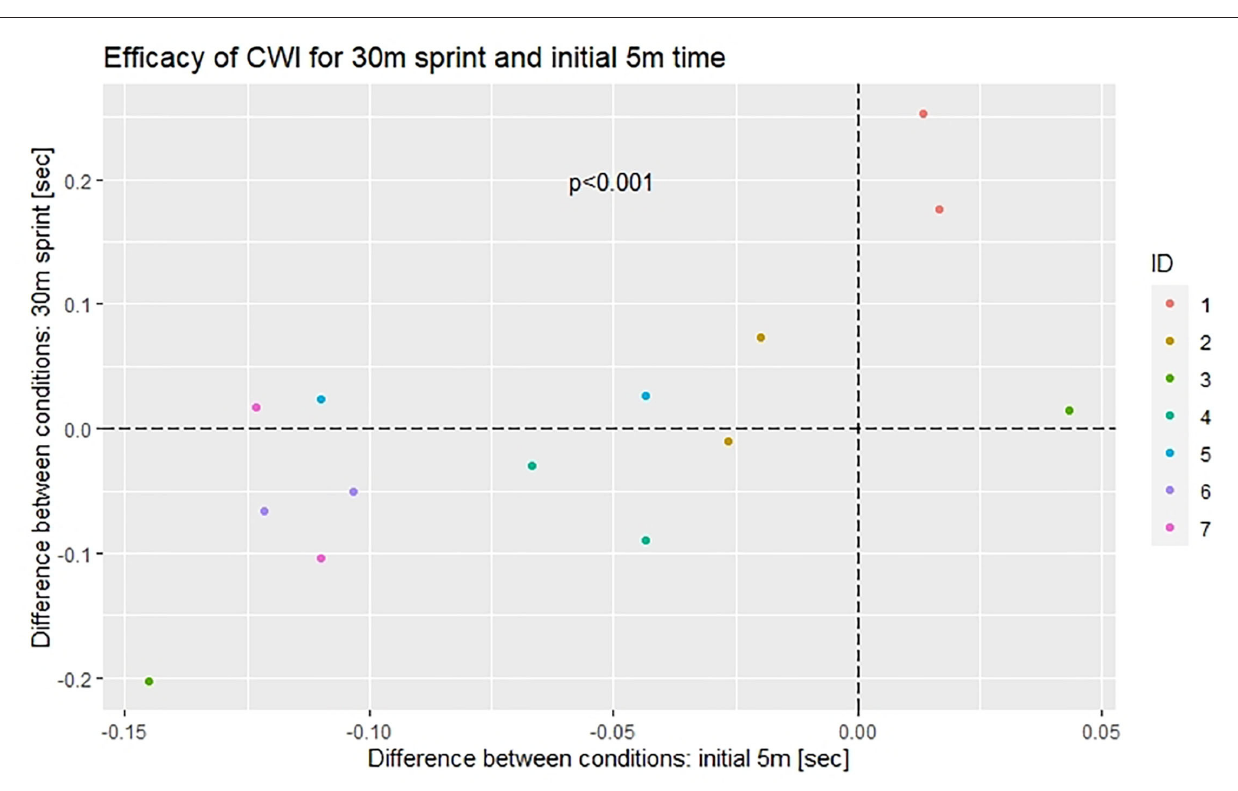
Differences in pre-post changes between conditions for the two distances are correlated ( Figure 2 ) with a fairly good reproducibility of response patterns on the individual level